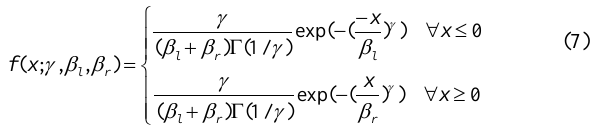
Figure 1. Two regions from ZY3 multispectral image (four bands with spatial resolution 5.8m) in Wuhan city and their histograms. The image patches are 200x200 and have been stretched and zoomed for display